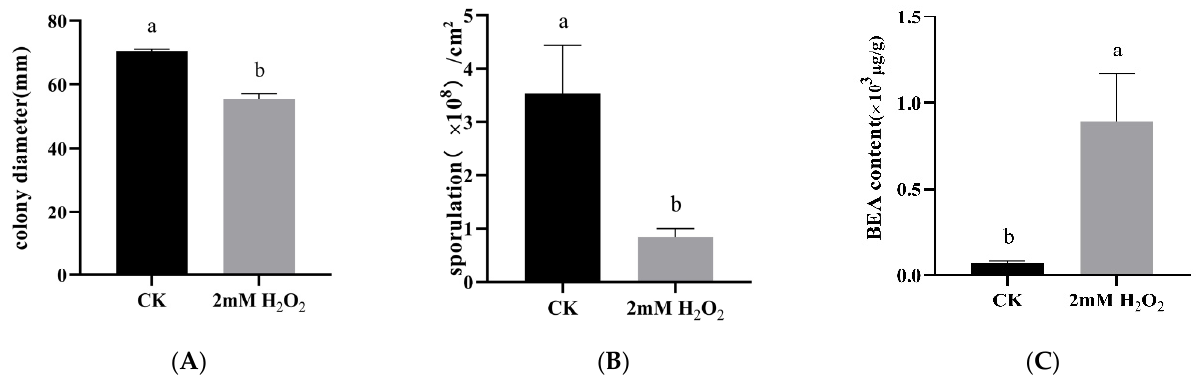
Figure 1. ( A ) Effect of H 2 O 2 on the growth of C. chanhua . ( B ) Effect of H 2 O 2 on the sporulation of C. chanhua . ( C ) Effect of H 2 O 2 on the BEA content of C. chanhua. CK, control, without H 2 O 2. Different Lower letters indicate significant difference ( p < 0.05).